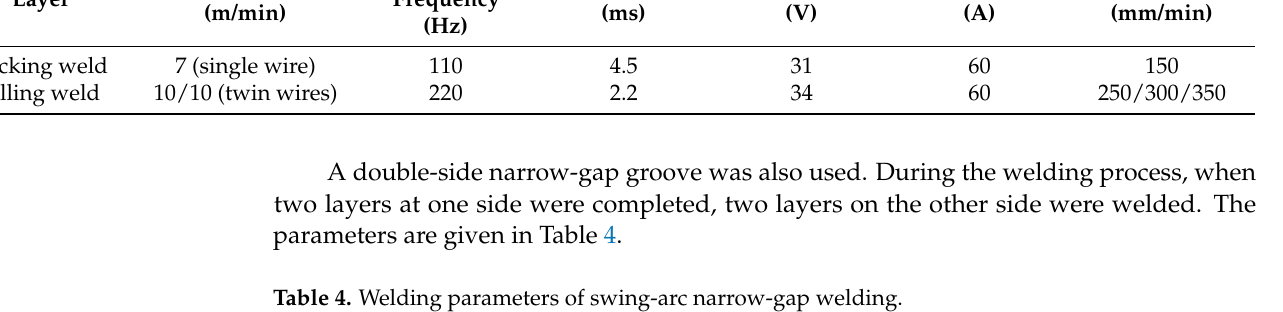
Table 4. Welding parameters of swing-arc narrow-gap welding.